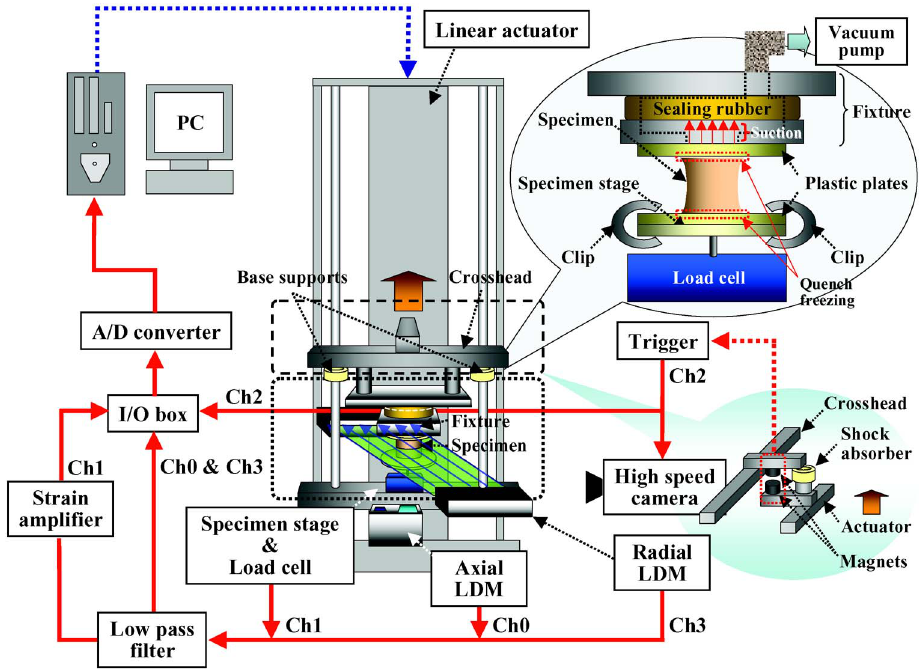
Fig. 1: Schematic diagram of the test apparatus for high-rate